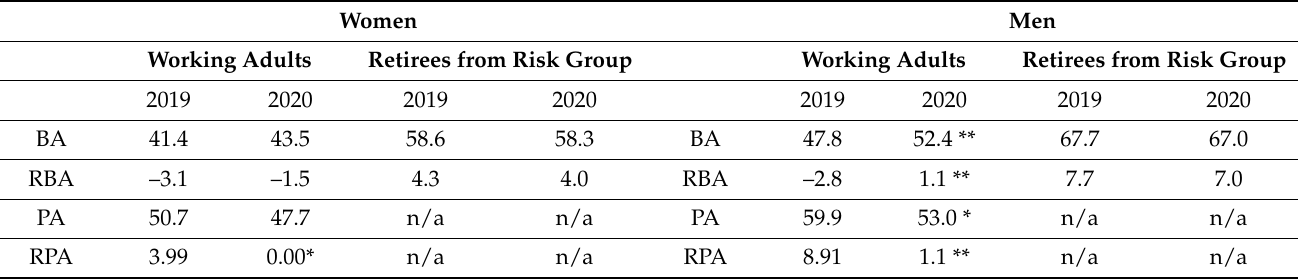
Table 1. Dynamics of biopsychological age indicators for men and women in 2019 and